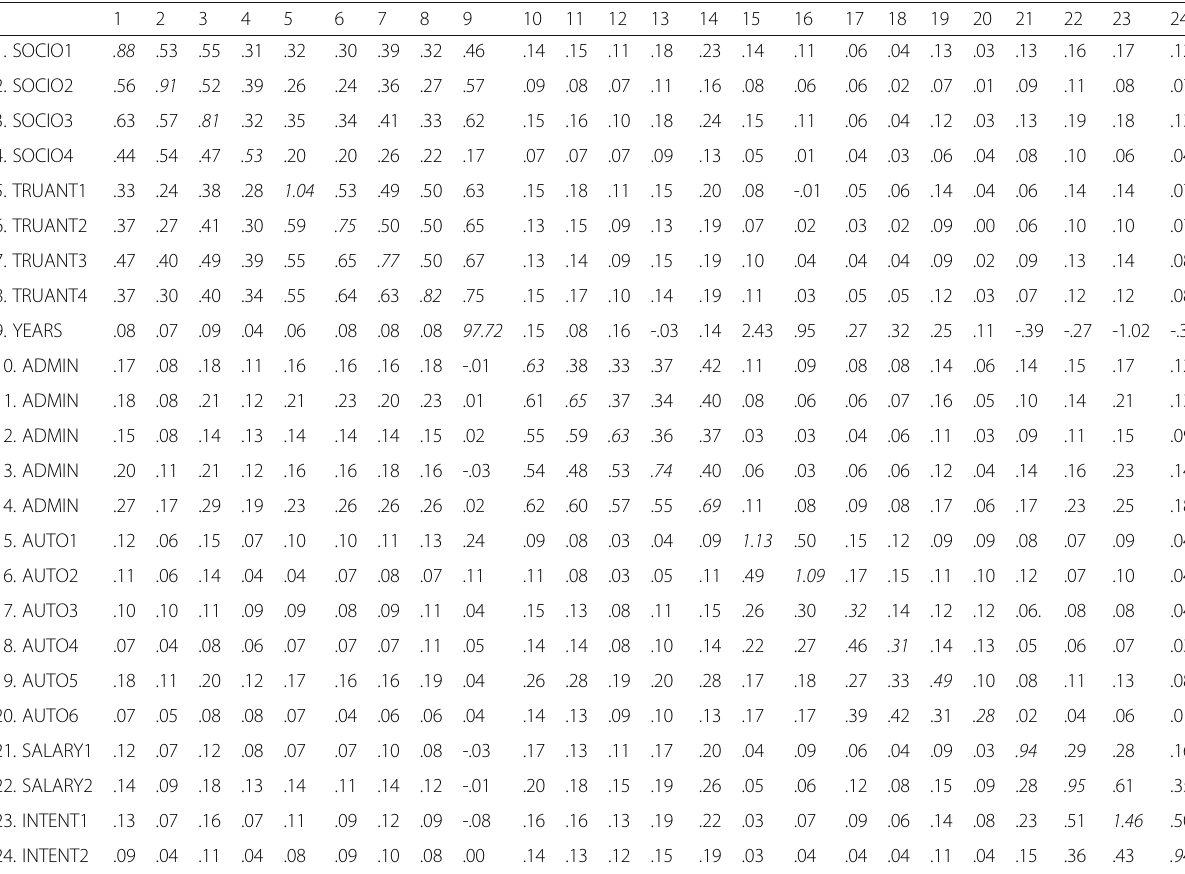
Table 8 Correlations ( lower left triangle ), variances ( diagonal ), and c ovariances ( upper right triangle